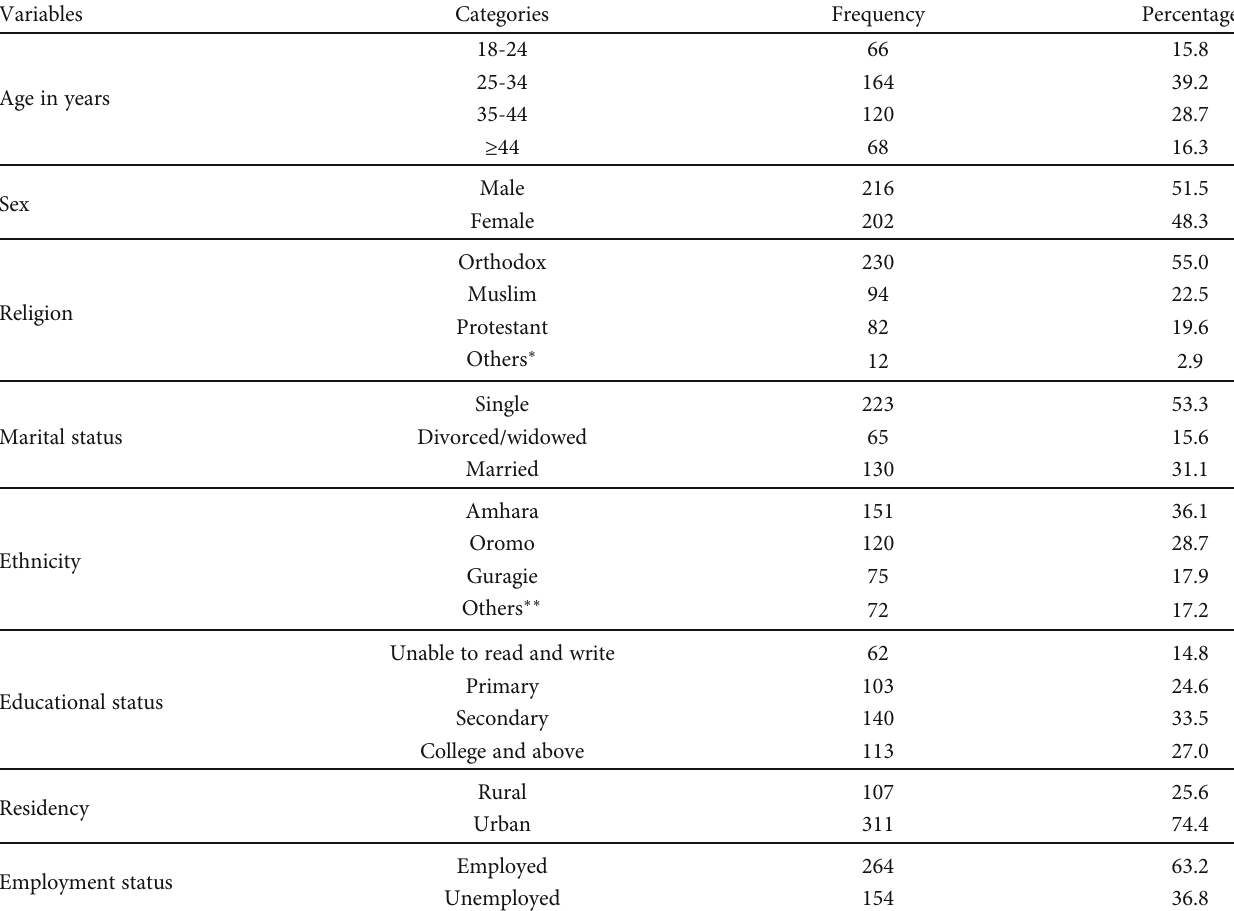
Table 1: Sociodemographic characteristics of people with bipolar disorder attending the outpatient department at Amanuel Mental Specialized Hospital, Addis Ababa, Ethiopia, 2016 ( n = 418